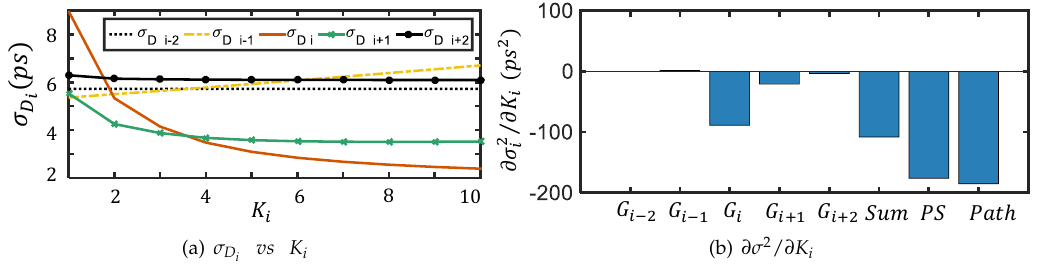
Figure 3. ( a ) changes in the delay standard deviation as gate G i is sized-up in Figure 2; ( b ) changes in the delay variances as gate G i of Figure 2 is sized-up by an amount ∆ K i